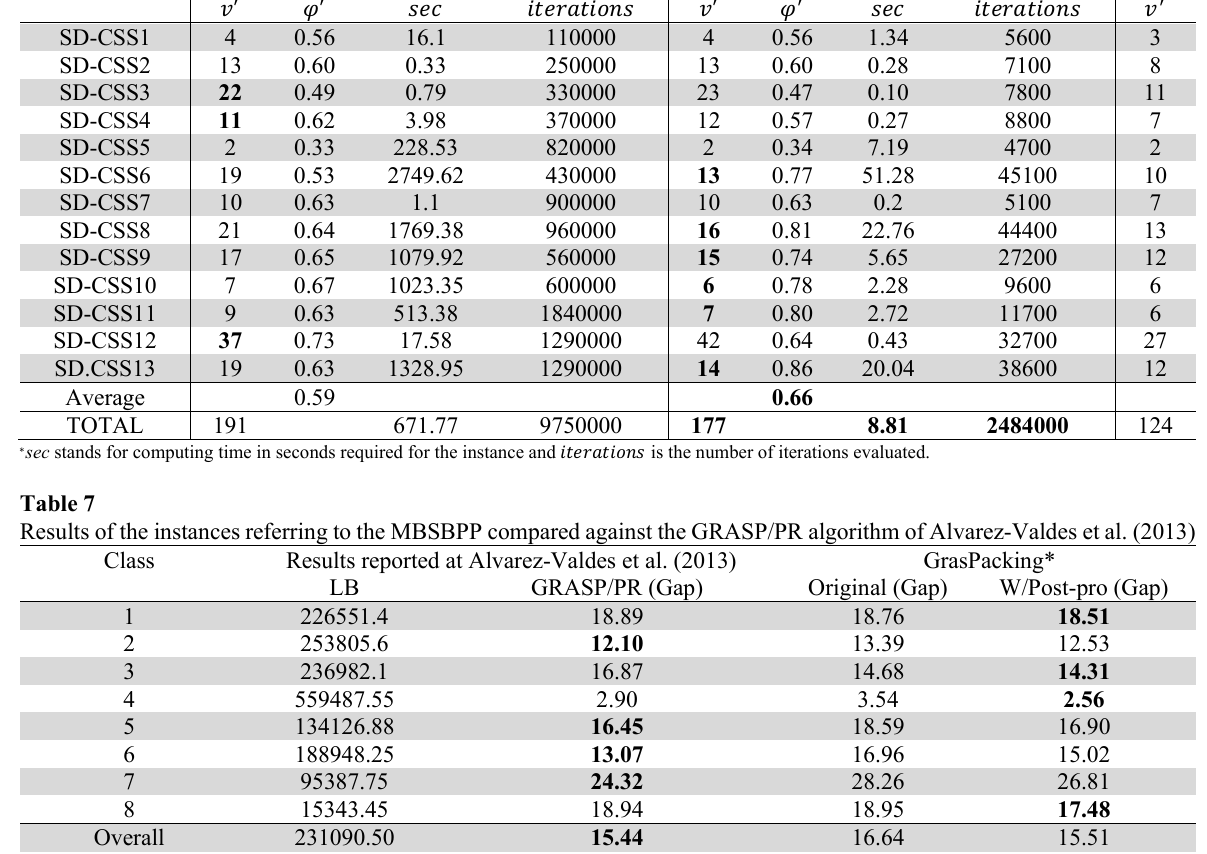
Results of the instances referring to the MBSBPP. Compared against the SA-LNS algorithm of Ceschia and Schaerf (2013) Instance